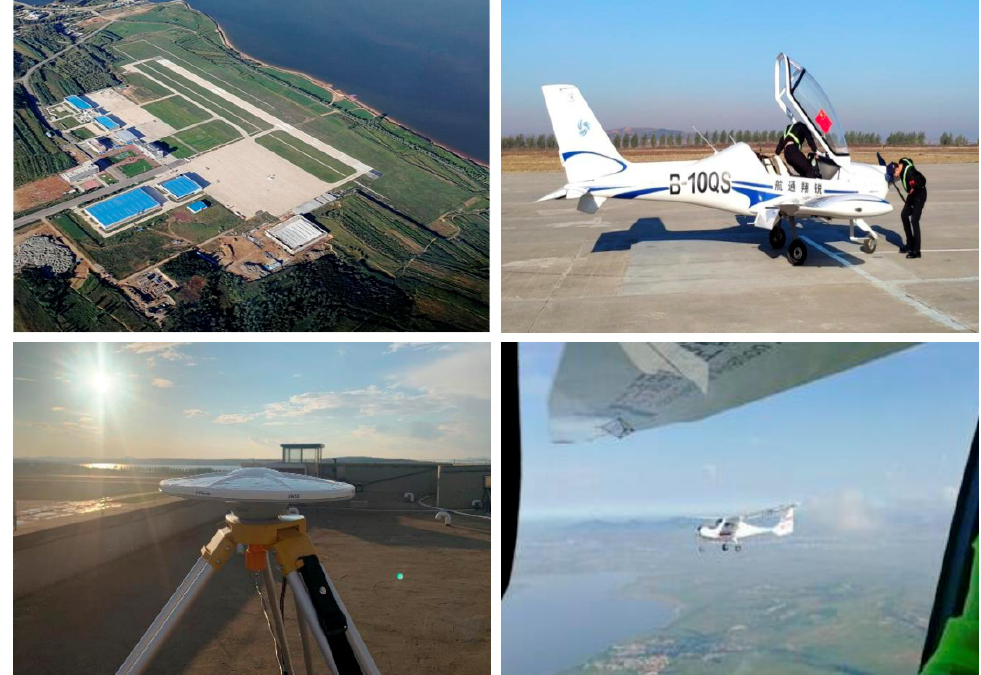
Figure 8. The figure presents the flight test environment. The top left panel is the aerial view of Shenyang Caihu Airport. The top right panel is the B-10QS general aviation aircraft which was used in the test. The bottom left panel is the RTK reference station installed at the airport. The bottom right panel is a photo of the B-10QS aircraft taken by another companion aircraft during the flight.